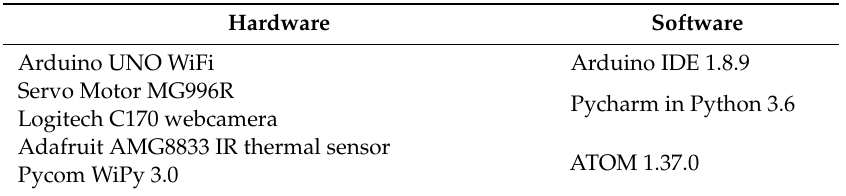
Table 2. Hardware and software platforms used in the intelligent lecturer tracking and capturing (ILTC) system.